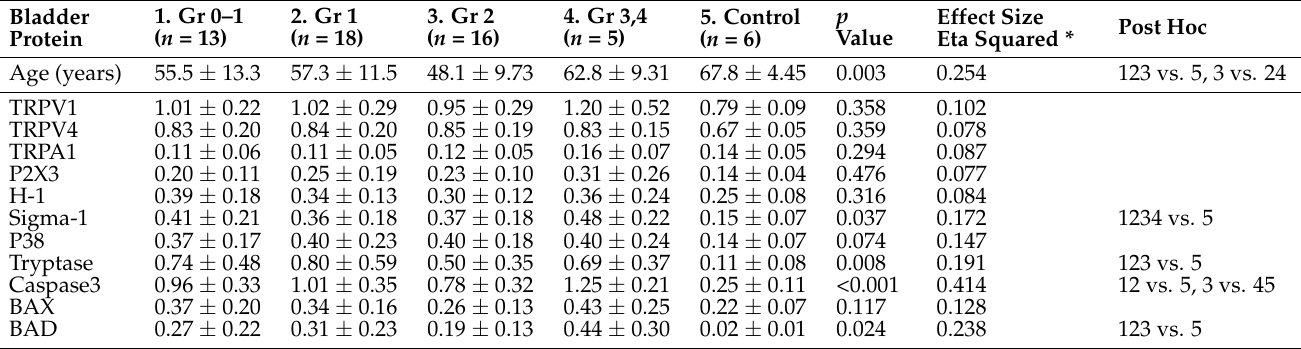
Table 4. Sensory, inflammatory, and pro-apoptotic protein expression levels in the urothelium of patients with interstitial cystitis/bladder pain syndrome with different grades of glomerulations and controls. Bladder